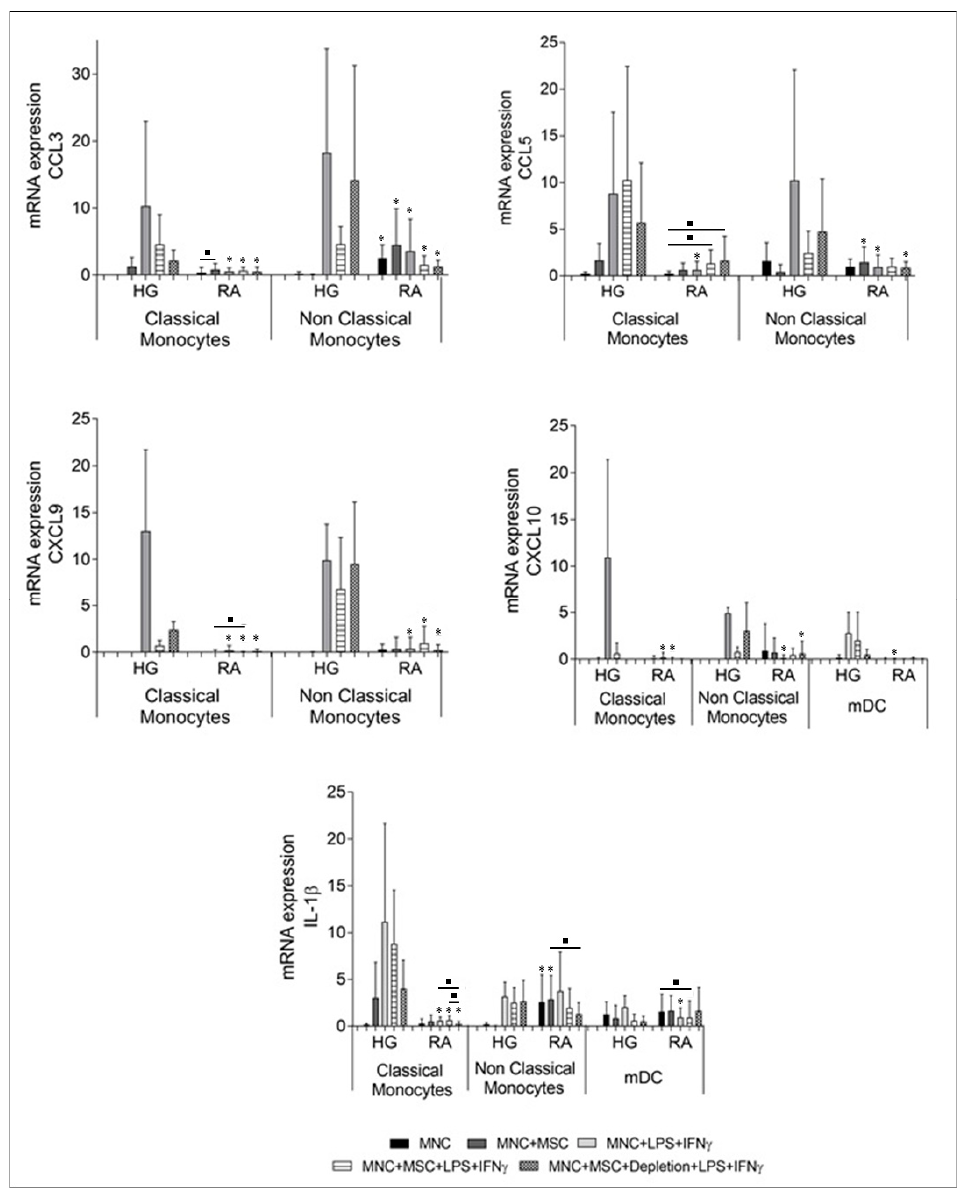
Figure 6. Effects of BM-MSCs over cytokines and chemokines mRNA expression by monocytes and mDCs from healthy individuals and RA patients. Semi-quantitative determination of CCL3, CCL5, CXCL9, CXCL10 and IL-1 β mRNA expression in FACS-purified classical monocytes and non-classical monocytes, and of CXCL10 and IL-1 β in mDCs. mRNA levels were measured under the following culture conditions: non-stimulated PBMCs (MNC), non-stimulated PBMCs in co-culture with MSCs (MNC + BM-MSC), PBMCs stimulated with LPS plus IFN γ (MNC + LPS + IFN γ ), PBMCs in co-culture with MSCs and stimulated with LPS plus IFN γ